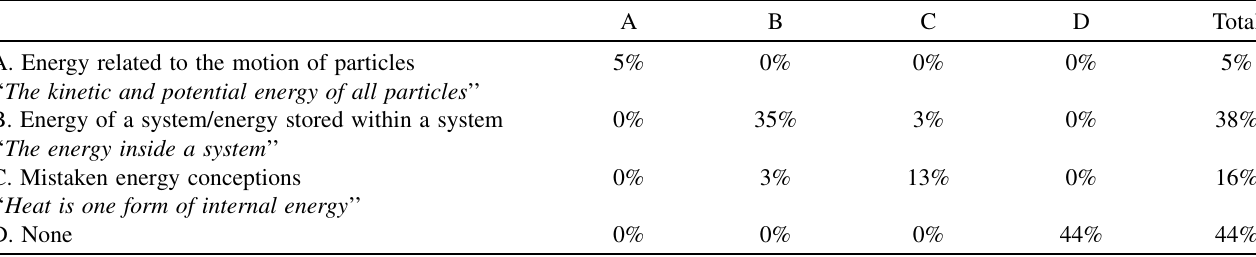
TABLE V. Categorization of students’ conceptions of internal energy. Categories A–C refer to the same categories in rows and columns. N ¼ 75 . A typical example from each category is presented after the category symbol in